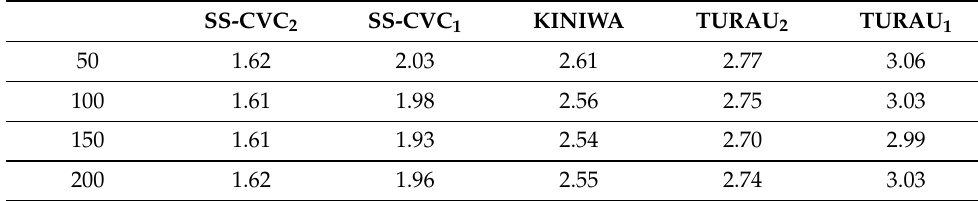
Table 2. Approximation ratios of algorithms (Avg. degree = 5).